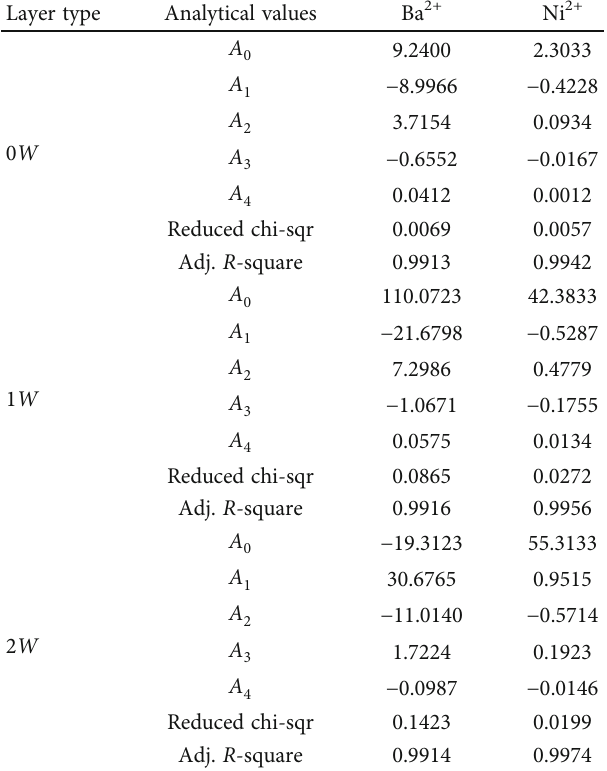
Table 7: Theoretical value deduced from polynomial regression fi tting which is used to study the evolution of the layer type abundance.